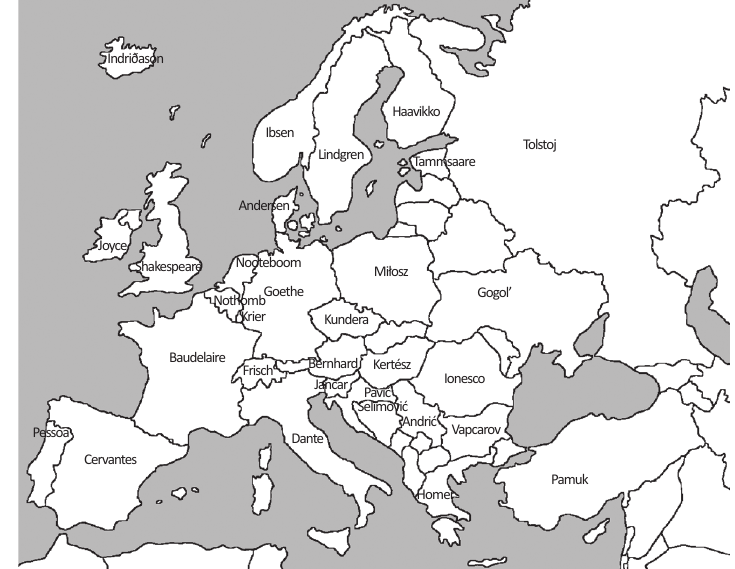
auf der literarischen Karte Europas aus der Sicht der befragten deutschen Studierenden